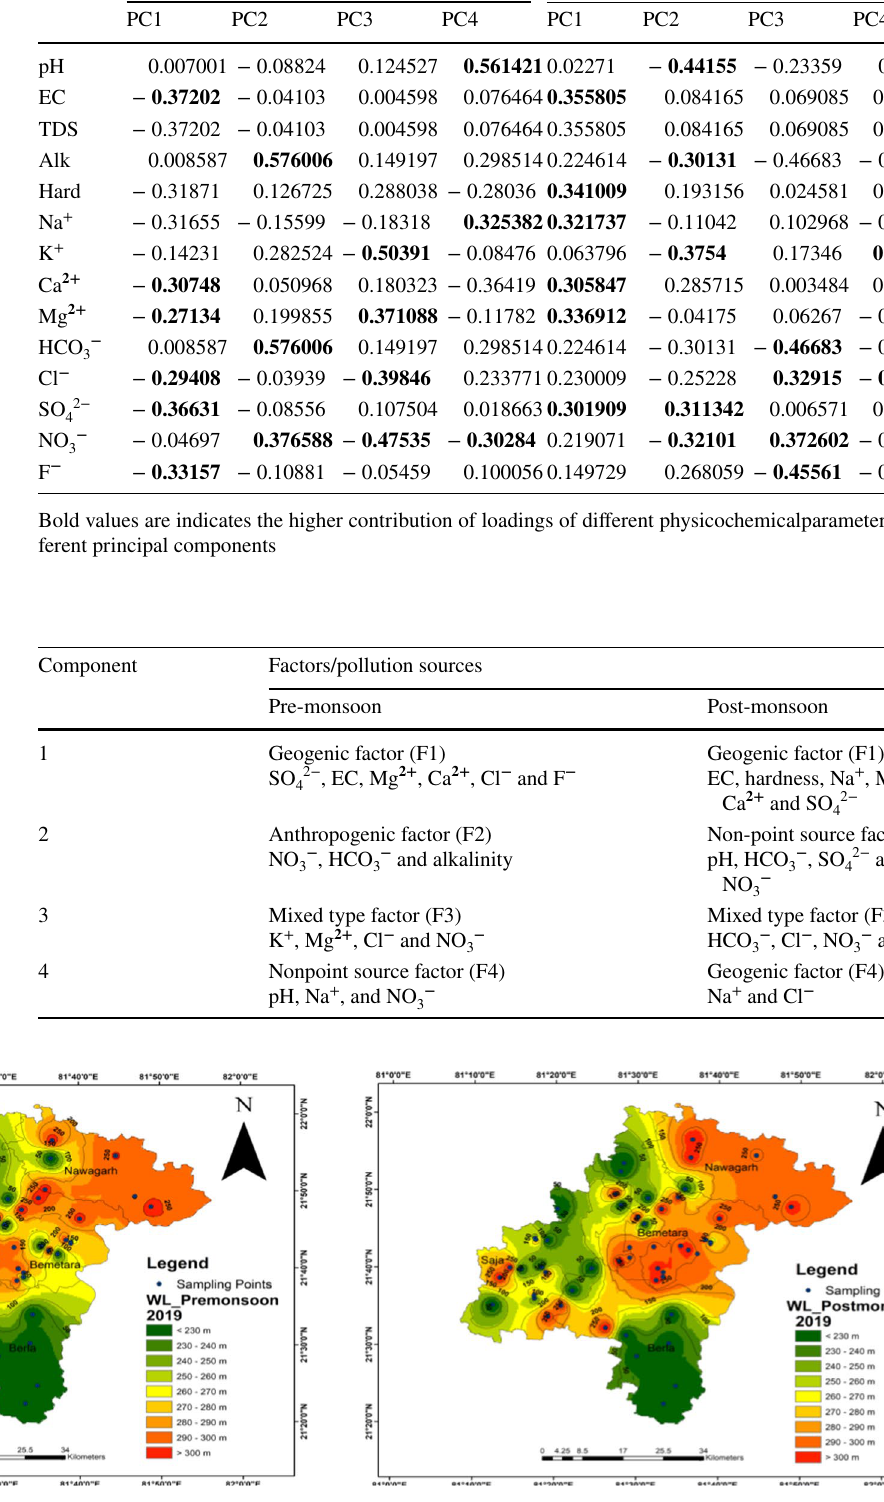
component loading (pre- and post-monsoon)